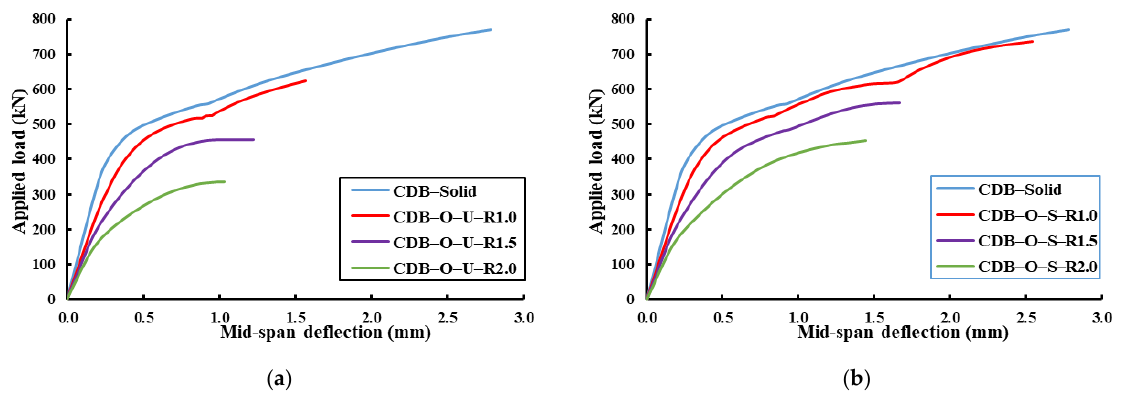
Figure 13. Effect of the ratio of the opening dimensions on the behavior of RCCDBs. ( a ) Un-strengthened beams; ( b ) strengthened beams.